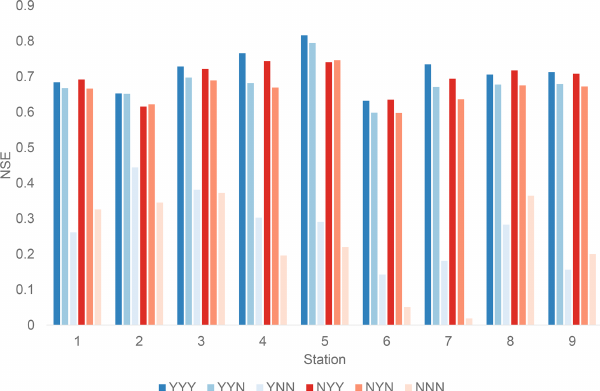
Figure C1. The results of sensitivity analysis on river discharge. See Table C1 for simulation runs. YYY and NNN correspond to the GLB and LOC simulations,